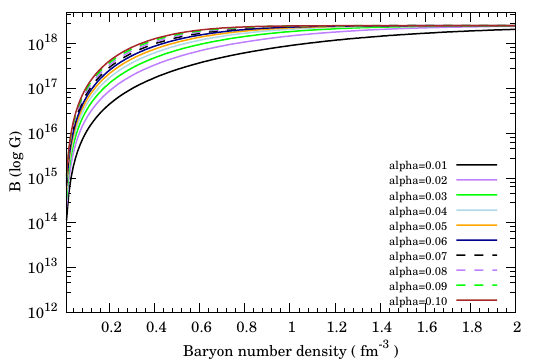
Figure 2. B( ρ ) as a function of baryon number density ρ for various α parameters with B 0 = 2.5 × 10 18 G and γ = 2. The colored lines represent the following: black (solid line), magnetic fields B ( ρ ) with α = 0.01; purple (solid line), magnetic fields B ( ρ ) with α = 0.02; green (solid line), magnetic fields B ( ρ ) with α = 0.03; light blue (solid line), magnetic fields B ( ρ ) with α = 0.04; orange (solid line), magnetic fields B ( ρ ) with α = 0.05; dark blue (solid line), magnetic fields B ( ρ ) with α = 0.06; black (dashed line), magnetic fields B ( ρ ) with α = 0.07; purple (dashed line), magnetic fields B ( ρ ) with α = 0.08; green (dashed line), magnetic fields B ( ρ ) with α = 0.09; brown (solid line), magnetic fields B ( ρ ) with α = 0.10.